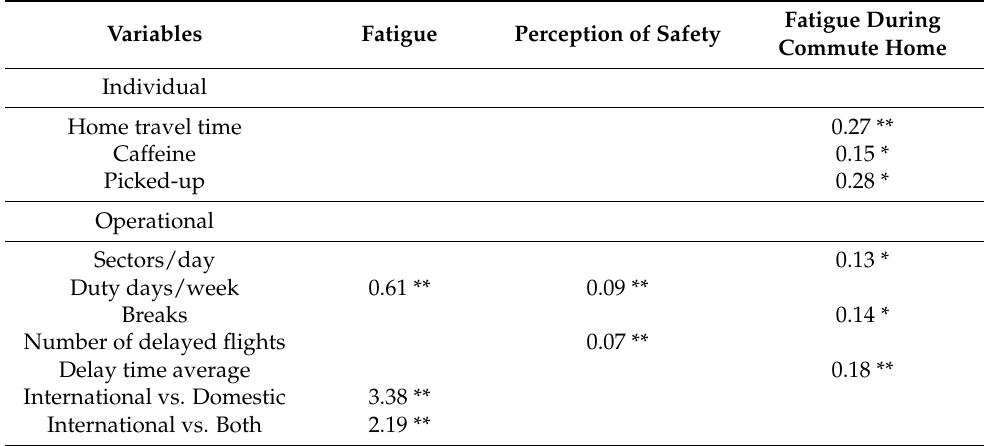
Table 6. Summary of beta values on fatigue, perception of safety and fatigue during commute